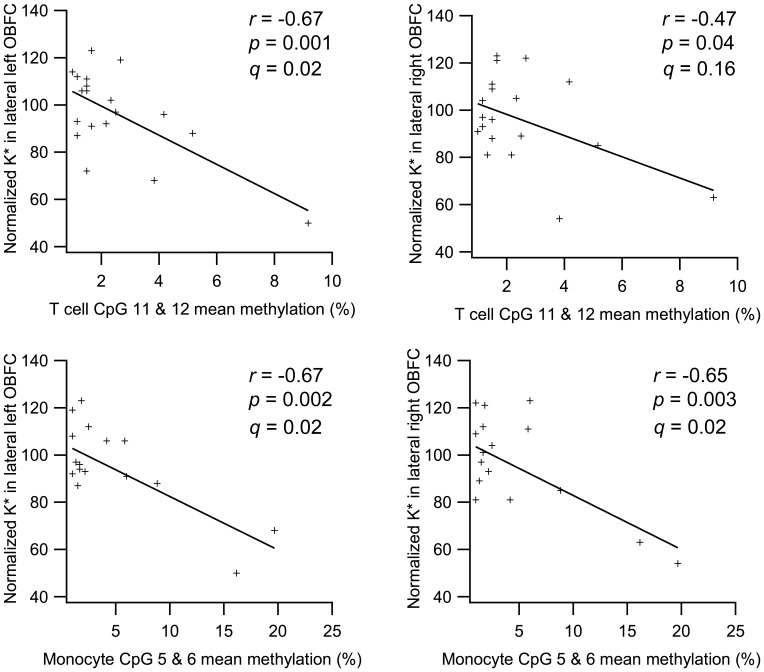
Correlations between peripheral methylation and brain 5-HT synthesis.In the upper panel, mean percentage of CpG site 11 and 12 methylation in T cells (n = 20) was negatively associated with the in vivo index of 5-HT synthesis (normalized K* value) in the lateral left (r = −0.67, p = 0.001) and right OBFC (r = −0.47, p = 0.04). FDA was used to adjust for multiple testing (q = 0.02 and q = 0.16, respectively). Bottom panel shows similar associations of percentage of methylation of CpG site 5 and 6 in monocytes (n = 19) vs. lateral left (r = −0.67, p = 0.002) and right OBFC (r = −0.65, p = 0.003). For both regions, q = 0.02.